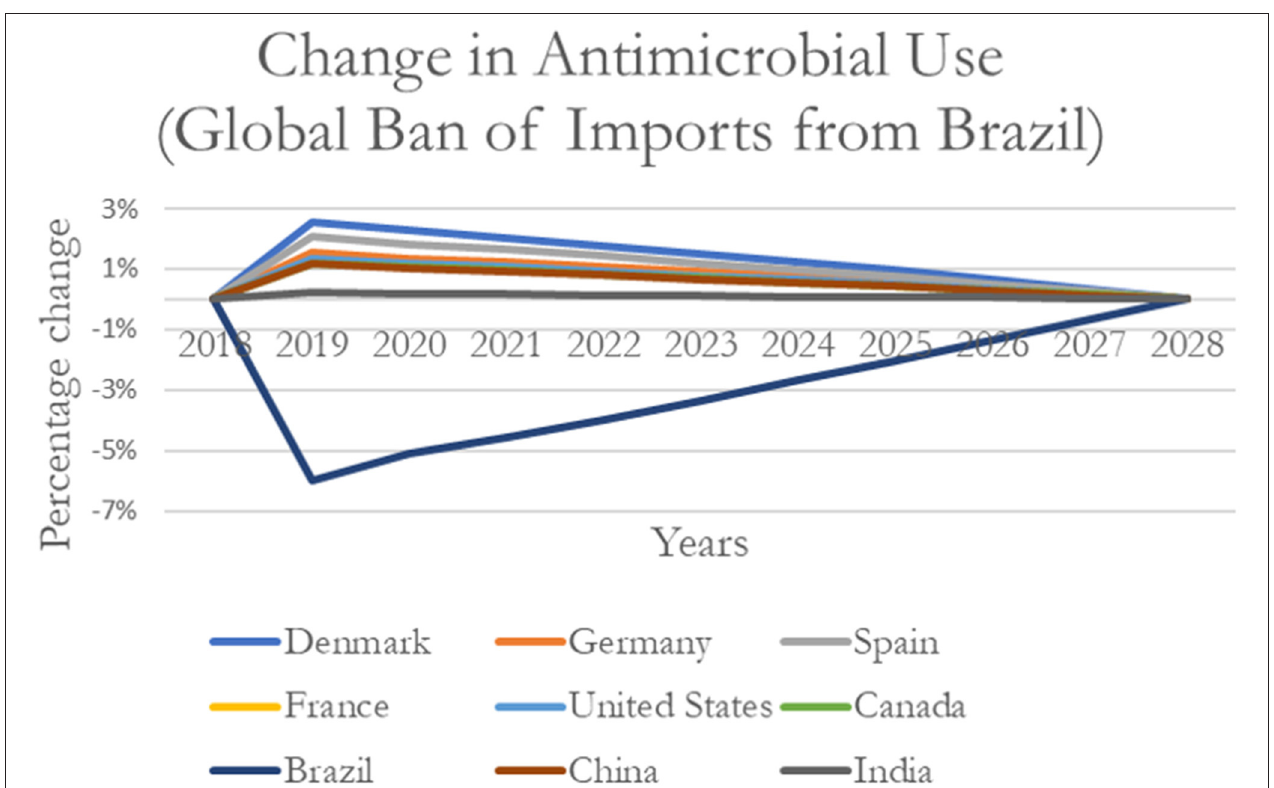
FIGURE 6 | Percentage change in antimicrobial use compared to reference antimicrobial use. The ban leads to a decrease in antimicrobial use in Brazil’s livestock production sector and an increase of antimicrobial use in the livestock production sectors of the other countries in 2019. Brazil’s livestock producers seek to increase their productivity by increasing antimicrobial use when allowed access to the international